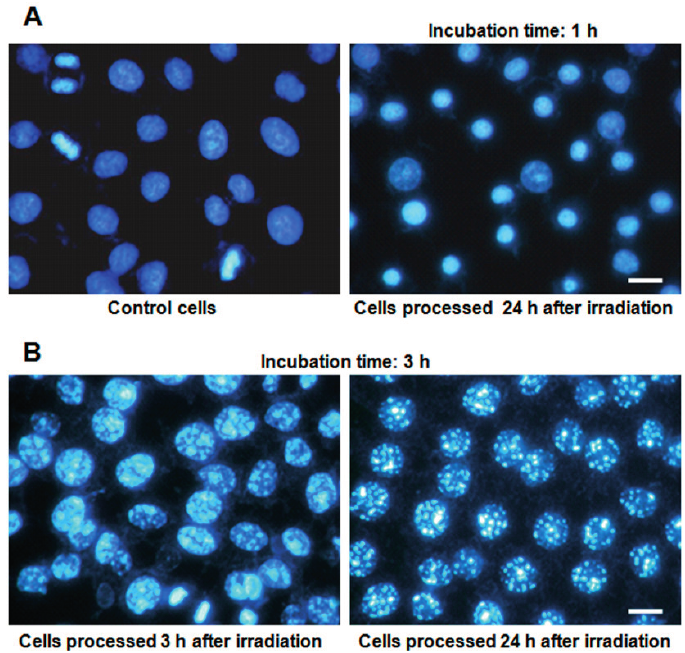
Figure 2. Nuclear morphology of H-33258-stained HeLa cells at different times after photodynamic treatments, observed in fluorescence microscopy under UV excitation